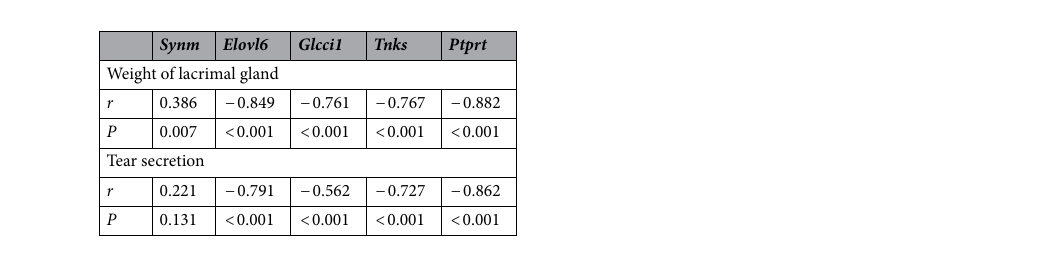
Figure 6. Validation of the marker genes screened by LASSO model using the test set. ( A ) Expression of the 5 marker genes in the test set. ( B ) Similar to the findings in the training set, the test set showed the high TG-score group had a higher risk of T2DM than the low TG-score group. ( C ) The ROC curve of the marker genes-model in the test set. The AUC of the model was 0.980(0.929–1.000). ( D ) The calibration curves for the possibility of T2DM in the test set. The C-index and the robust C-index were 1.000 and 0.978, respectively. *** P < 0.001.